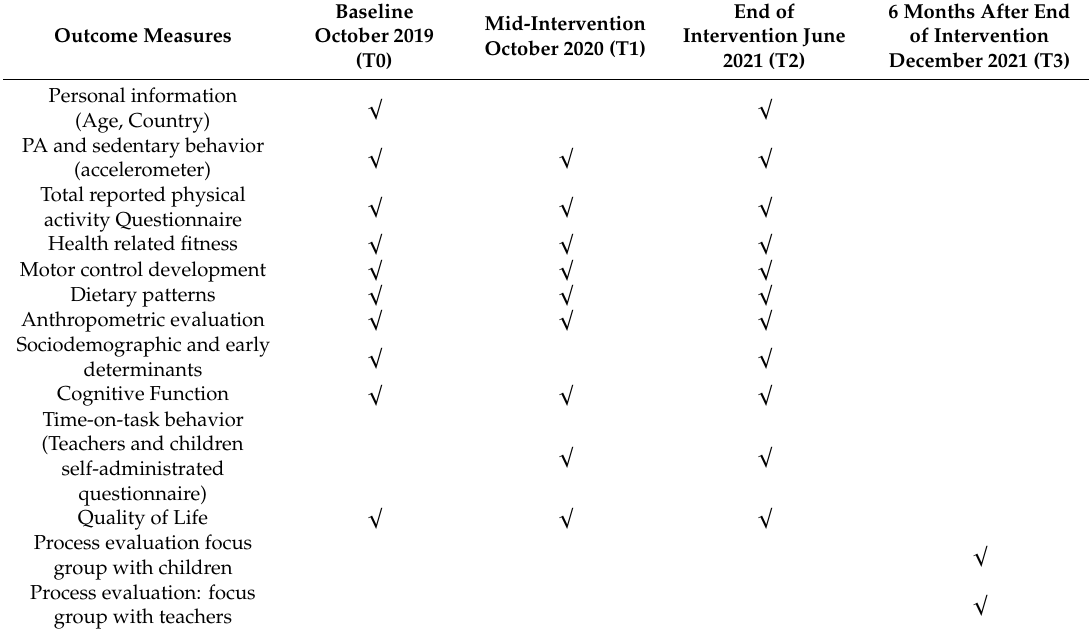
Table 2. The Imola Active Breaks Study data collection and outcome